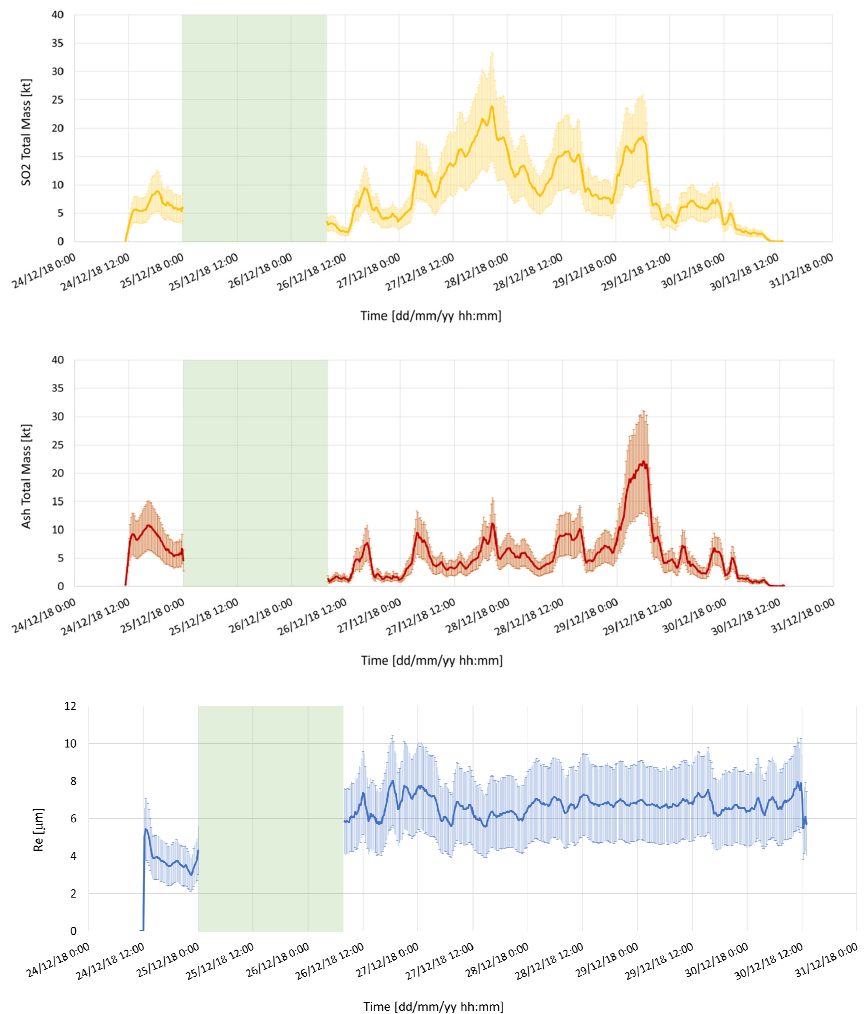
Figure 7. Time series of SO 2 total mass (upper plot), ash total mass (middle plot), and ash mean Re (lower plot) obtained from all the SEVIRI images with a 15-min time step. In green, the time interval for which a meteorological cloud system was over the Mediterranean region. The vertical bars represent the respective SEVIRI retrieval